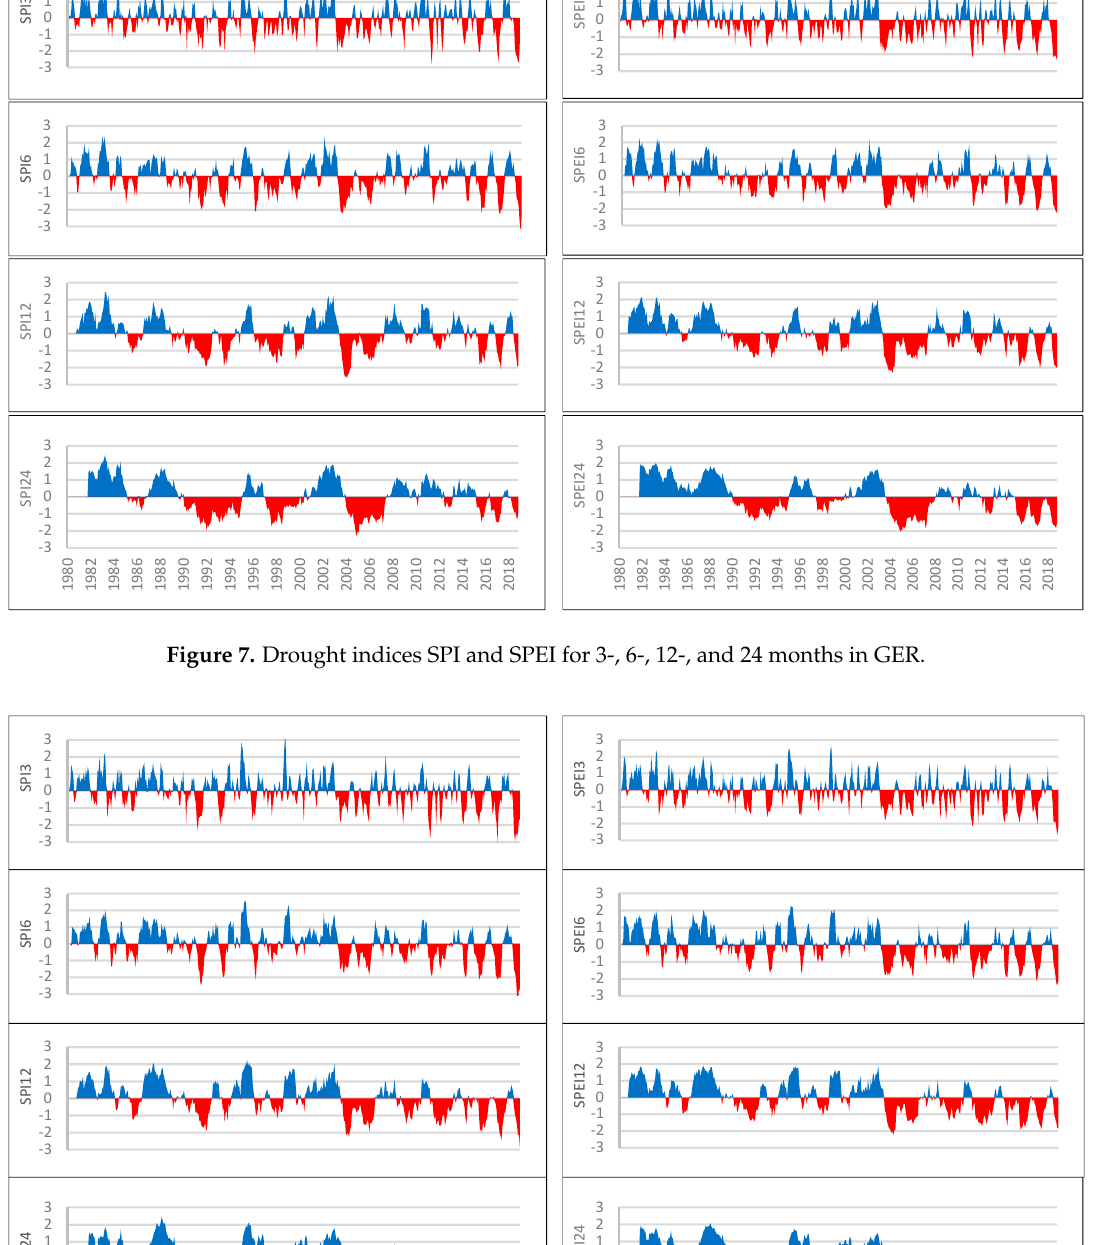
The SPI24 and SPEI24 take into consideration many months, usually resulting in